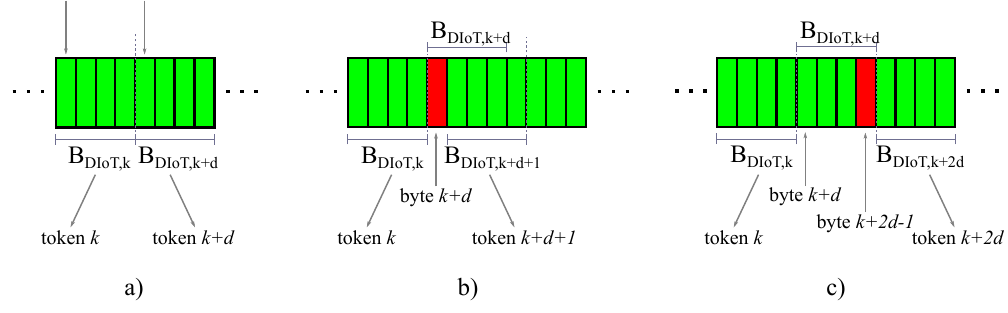
Figure 3. Examples of occurrences during file synchronization.